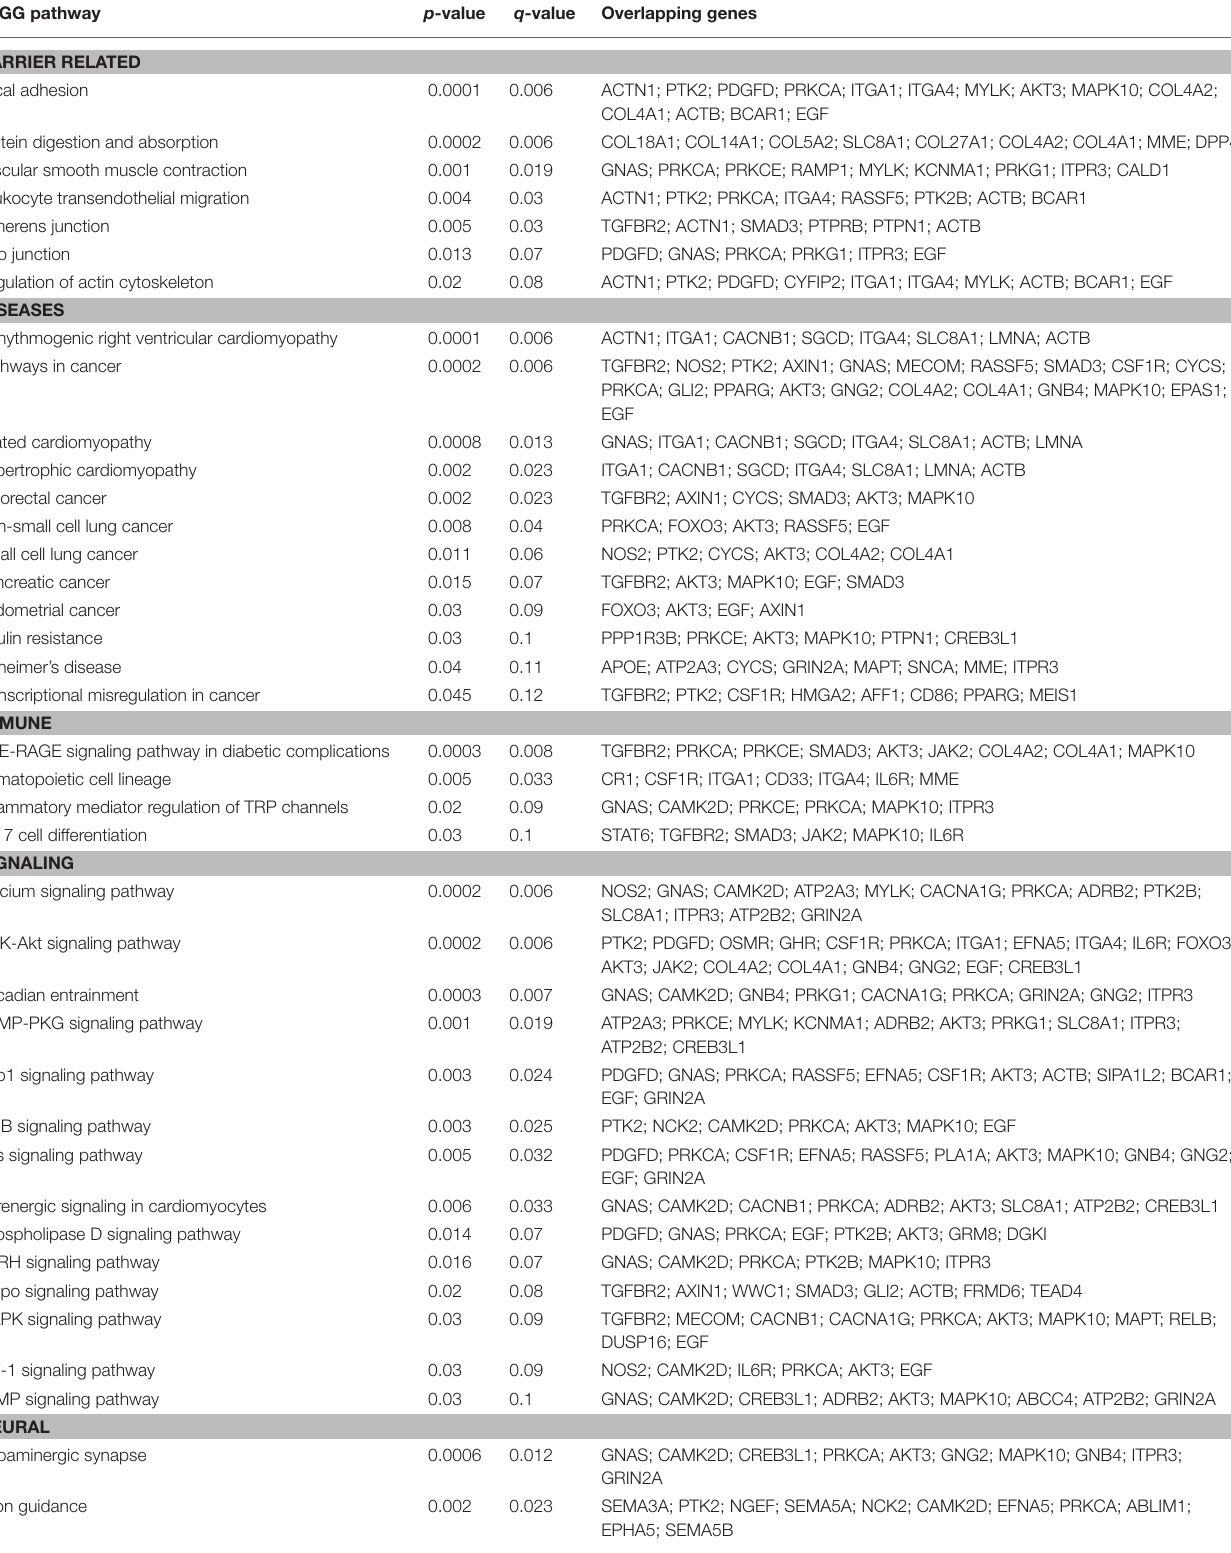
TABLE 2 | KEGG pathway enrichment analysis of the genes common to GWASdb AD genes and the P. gingivalis interactome. KEGG